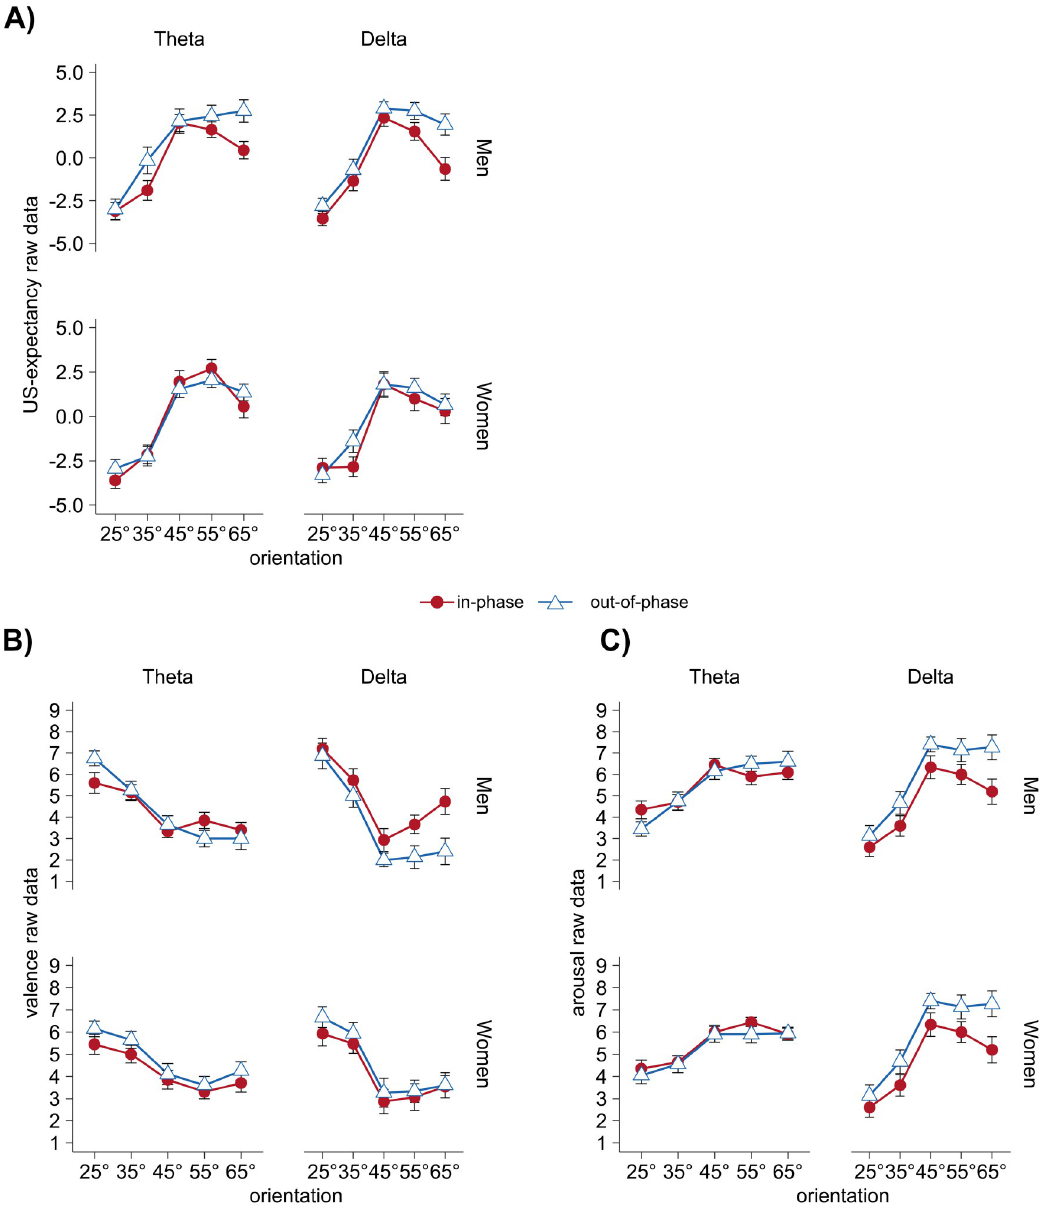
Fig 6. Valence, arousal, and US-expectancy data separately for men and women. US-expectancy ratings (A) , valence ratings (B) , and arousal ratings (C) after acquisition for each frequency (theta vs. delta) and synchronization (in-phase vs. out-of-phase), separated by sex: within each subplot, top row shows men (n = 80), bottom row shows women (n = 80). Each data point represents mean values for each CS orientation, separately for frequency, synchronization, and sex. Error bars show ± 1 SEM. In order to improve the visualization of the fear generalization pattern, we corrected for the linear trend during habituation, acquisition, and extinction: S5 Fig shows these habituation-corrected valence and arousal rating.